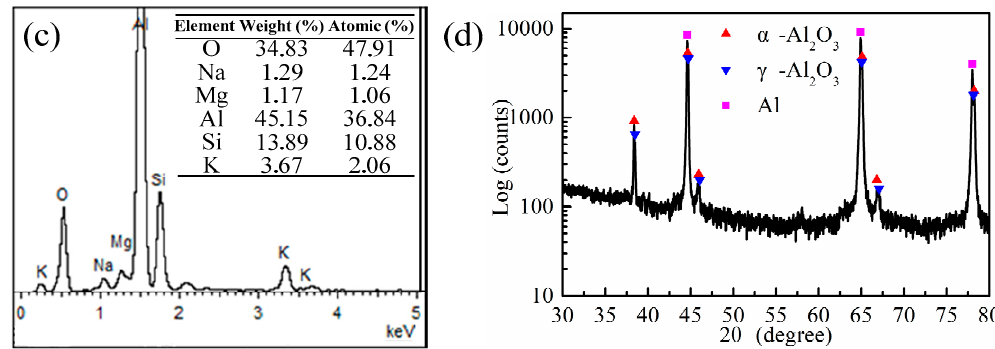
Figure 5. ( a ) Surface morphology, ( b ) cross-section, ( c ) chemical compositions, and ( d ) phases of the plasma electrolytic oxidation coatings.